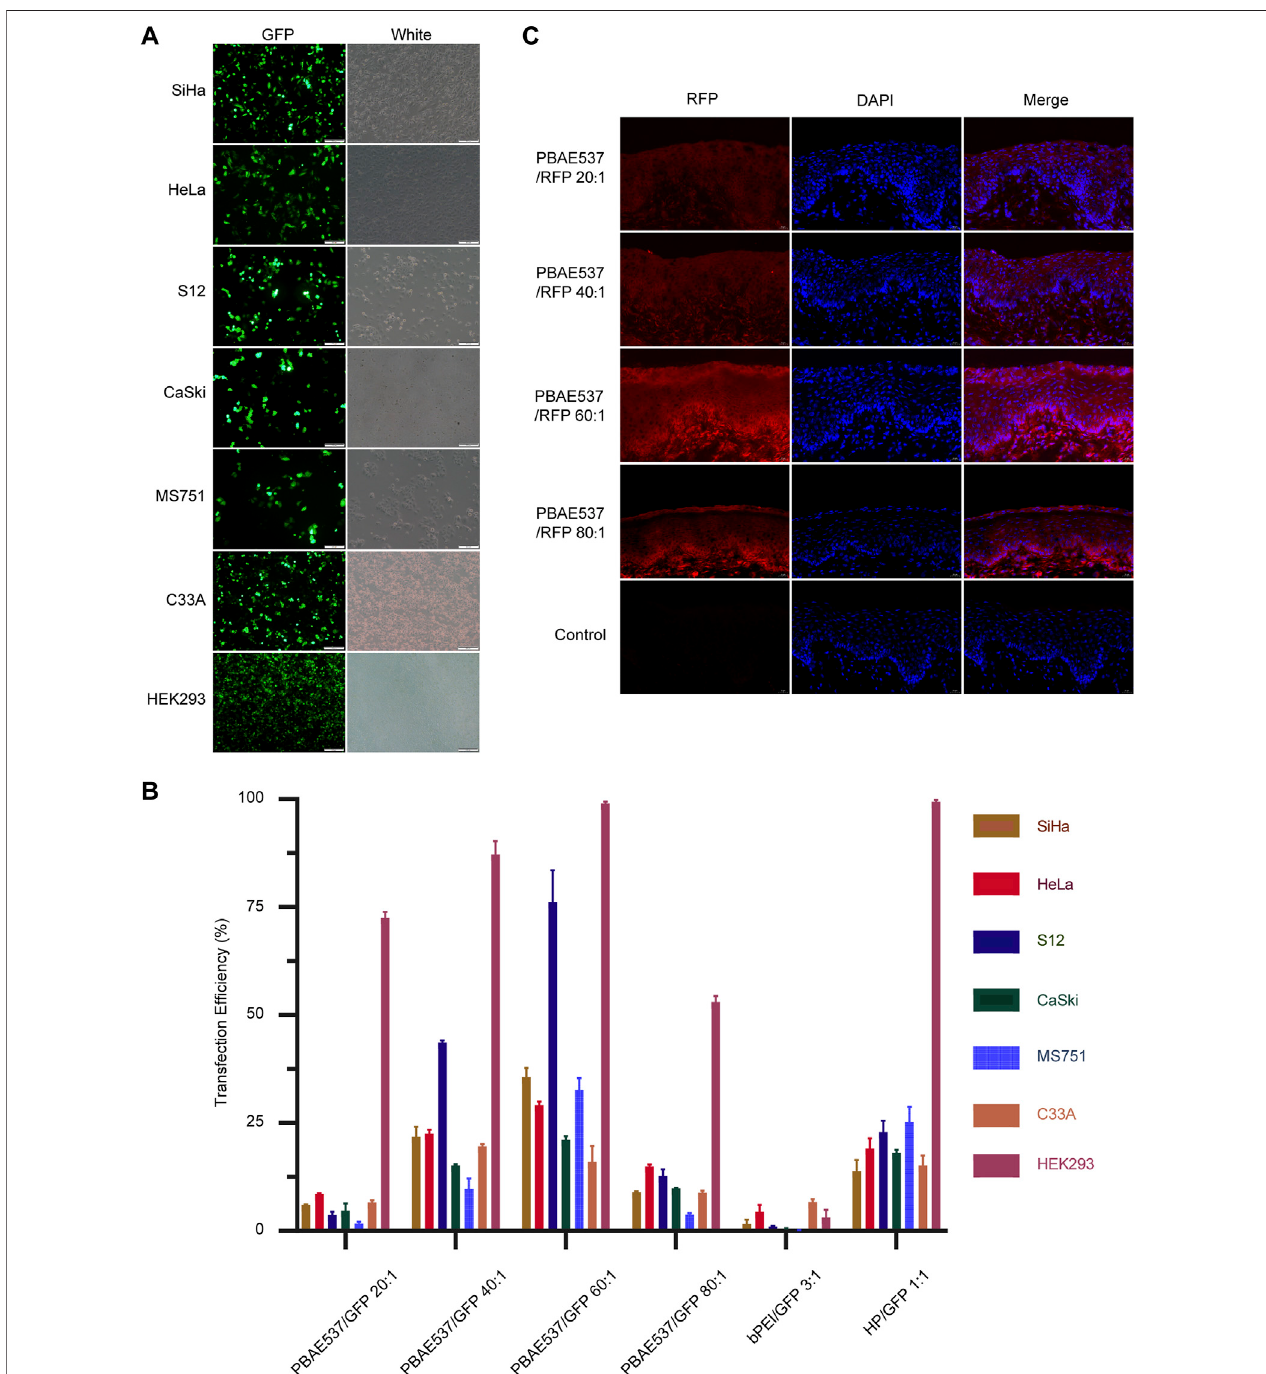
FIGURE 3 | Ef fi ciency of NPs taken up by cell lines and the mouse cervix. (A) Representative images of green fl uorescent protein expression in SiHa, HeLa, S12, CaSki, MS751, C33A, and HEK293 cells after 72 h of nanoparticle (PBAE537/GFP 60:1) treatment. (B) Flow cytometry was used to determine the ef fi ciency of nanoparticlestransfectedwithPBAE537/GFPatdifferentweightratios(20:1,40:1,60:1,and,80:1)andHP/GFP(1:1)fortheexpressionofthegreen fl uorescentprotein. bPEI is a cationic polymer with transfection ability used as a control. (C) Representative images of red fl uorescent protein expression in the cervix of the C57BL/6 micetreatedwithnanoparticlescomposedofdifferentweightratiosofPBAE537toRFP(10 μ gRFP,oncedaily,for3 days)comparedwiththecontrolcervixtreatedwith sodium acetate alone without nanoparticles. Scale, 20 μ m.